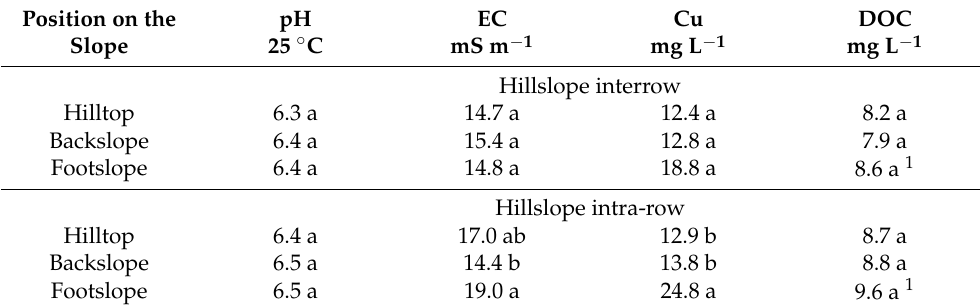
Table 2. Mean values of pH, electrical conductivity (EC), copper (Cu) and dissolved organic carbon (DOC) concentrations in leachates collected monthly for two years (2 November 2020–25 November 2022) from lysimeters installed at the hilltop, backslope and footslope of the vineyard inter- and intra-row. Position on the pH EC Cu Slope